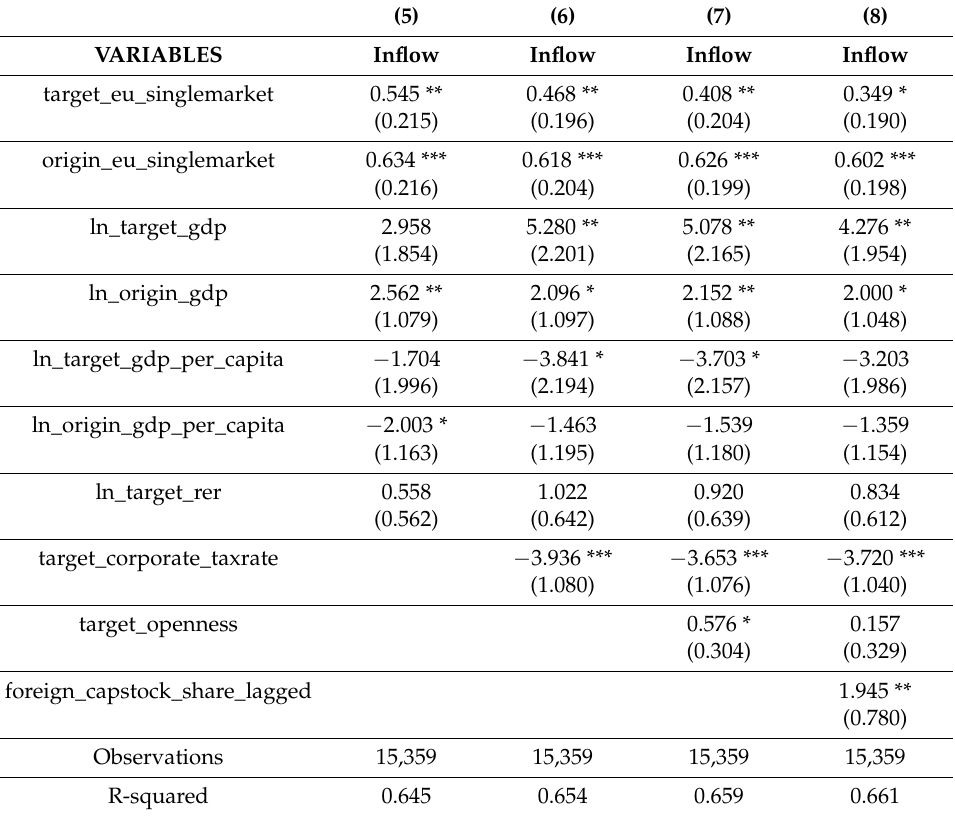
Table 4. Results for dyadic fixed panel data PPML estimation for FDI inflow, single market access as explanatory